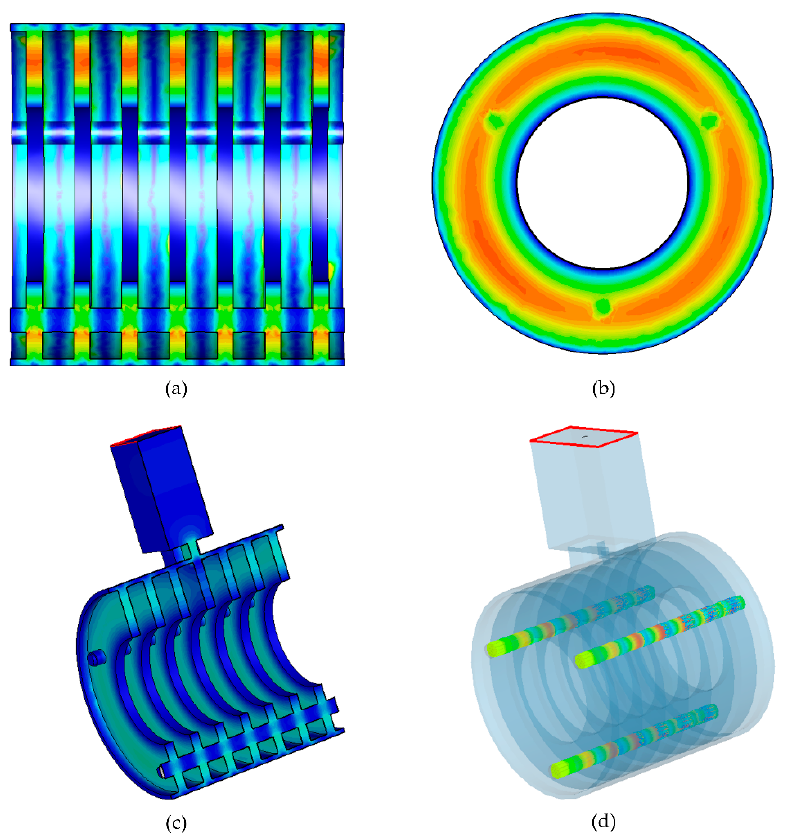
Figure 2. ( a , b ) Electric field contour of the operating mode with seven periods ( c ) Electric field E z contour at Y = 0 plane after oscillator. ( d ) Snapshot of the 3-D trajectory of the electrons within the device (device-0).